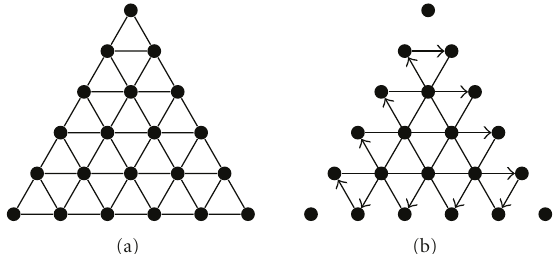
Figure 1: Configuration for which E routing / E coding = 2 d/ in a d -dimensional space, with connectivity given by r =